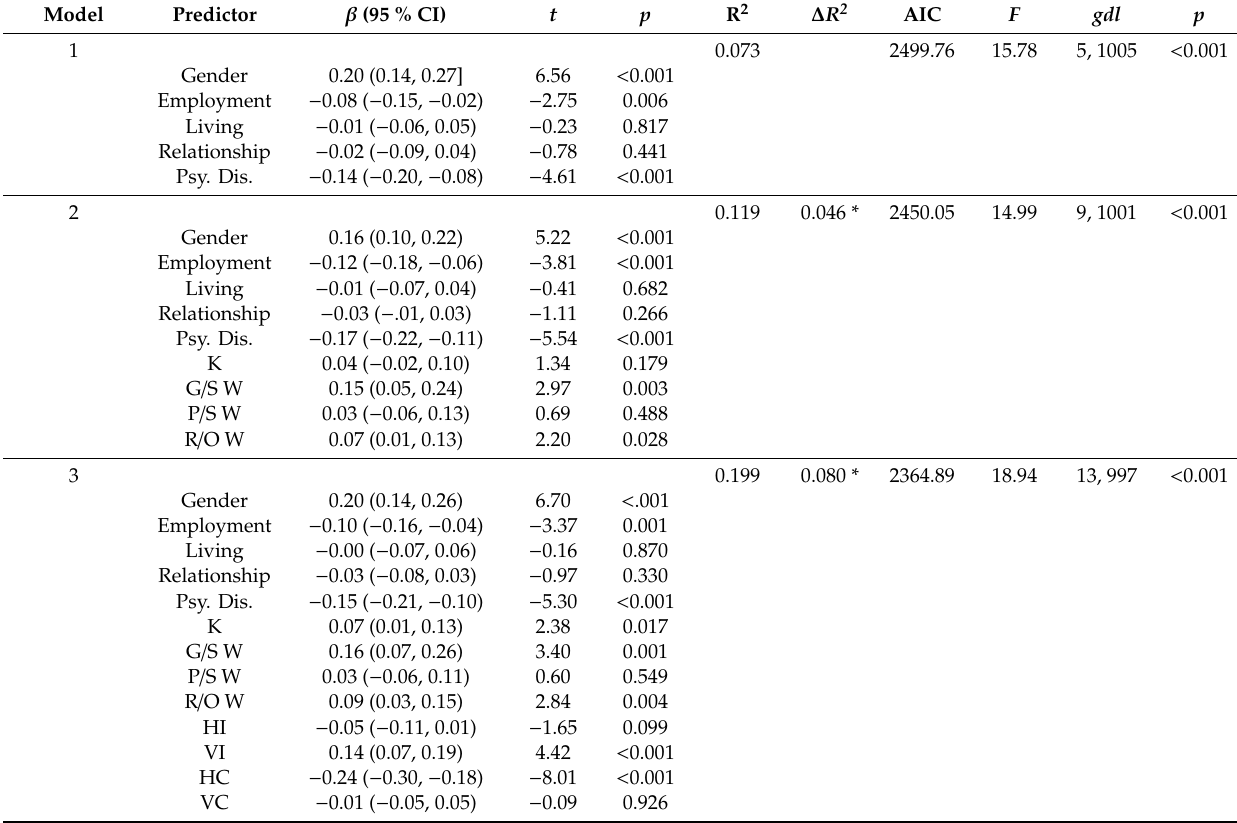
Table 4. Hierarchical multiple regression model of demographic variables, knowledge and worries and concerns about COVID-19 and INDCOL dimensions on psychological maladjustment composite score